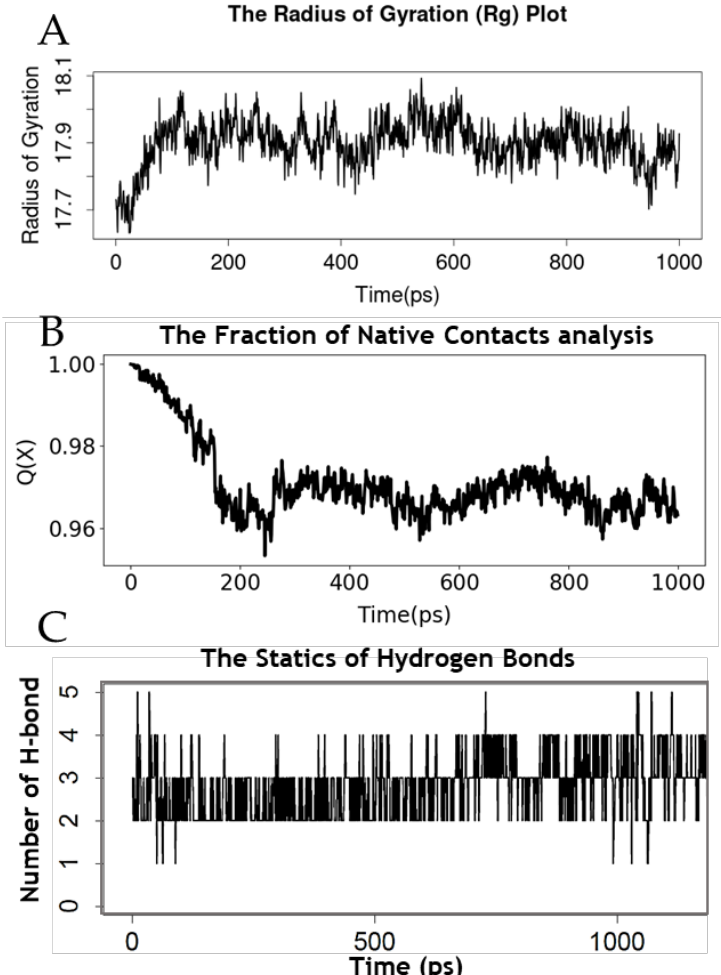
Figure 6. Molecular dynamics simulation of the Mpro – AVP4 complex; radius of teg gyrus plot ( A ), fraction of native contact analysis ( B ), and statistics of the hydrogen bonds ( C